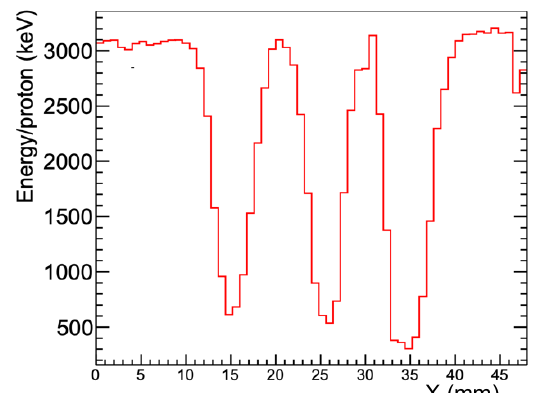
Fig. 6. One-dimensional horizontal projection obtained from the central slice of pixels for the row with 4-mm-diameter holes in the image of the sample with Derenzo pattern shown on the right-hand side of Fig.